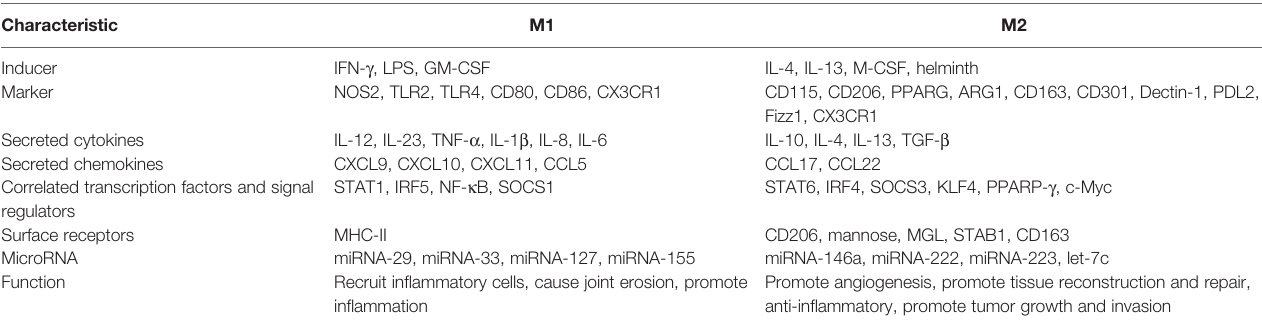
TABLE 2 | Characteristics of M1 macrophages and M2